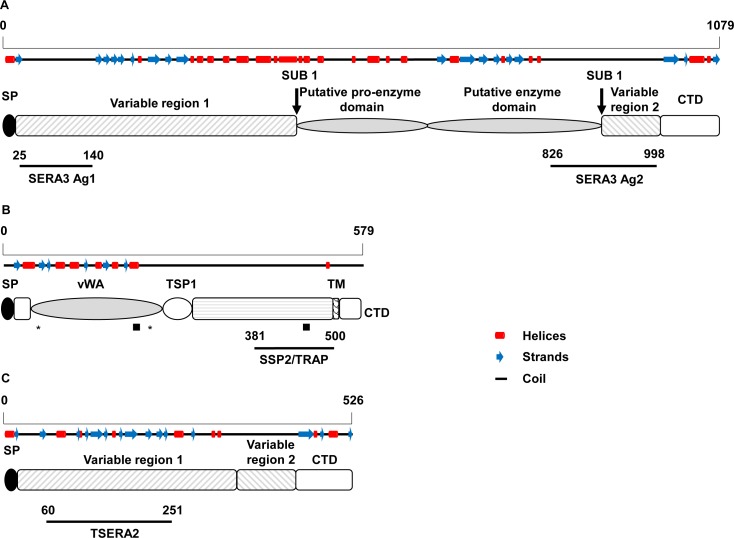
Plasmodium knowlesi-specific recombinant antigen constructs.Schematic representations for each protein are shown with key features labelled. (a) PkSERA3 shows the location of the putative pro-enzyme and enzyme domains. The predicted subtilisin (SUB) 1 cleavage sites in relation to variable regions 1 and 2 and the cytoplasmic domain [29]. (b) PkSSP2/TRAP contains a von Willebrandt A domain (vWA), thrombospondin type (TSP) 1 motif, a C-terminal transmembrane (TM) region and a cytoplasmic terminal domain (CTD). Putative T-cell and B-cell epitopes are highlighted with an asterix or black square, respectively [30]. (c) PkTSERA2 shows the lack of central enzyme domain due to truncation of the sequence [29]. Predicted secondary structures generated in I-Tasser [31] are shown above each scheme. Red boxes represent helices, blue arrows sheets and the black line coils. The position of recombinant proteins are highlighted below each scheme with the N- and C-terminal amino acid positions indicated. The overall length of each protein is referenced by the amino acid ruler above each secondary structure prediction. For all proteins SP refers to the signal peptide.